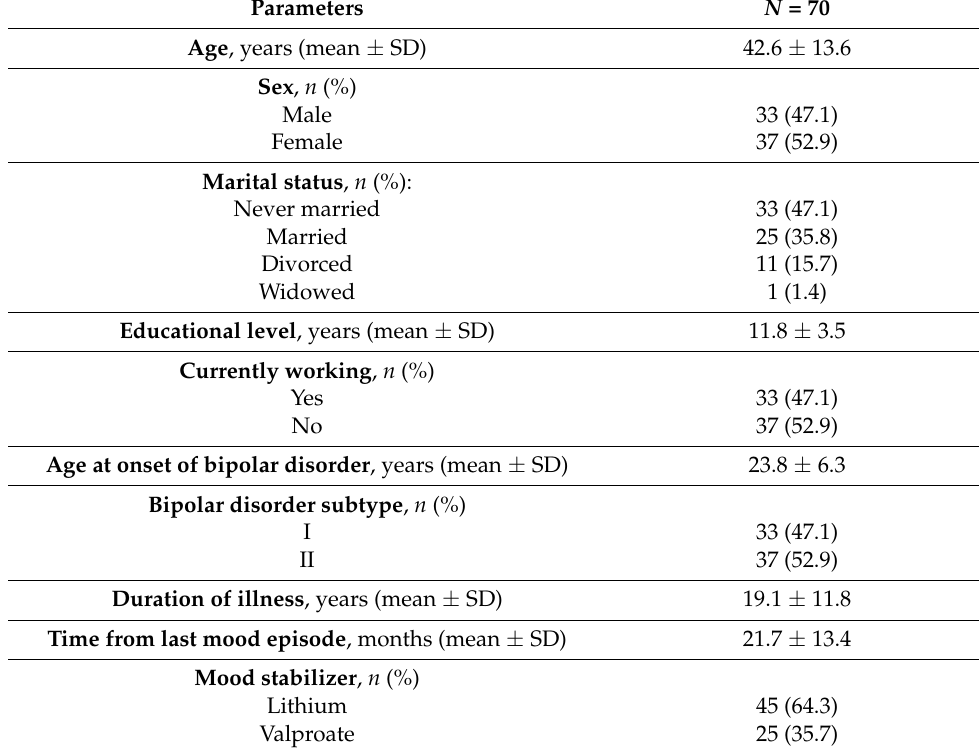
Table 1. Baseline demographic and clinical characteristics.